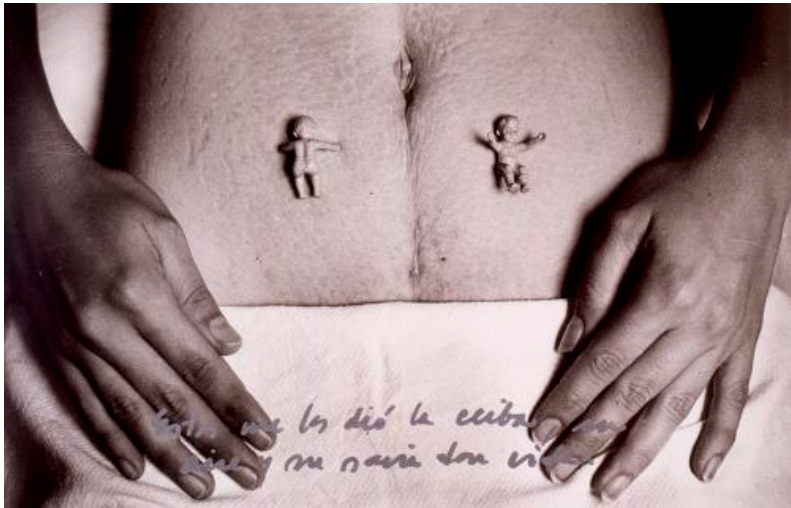
Figure 5. Marta María Pérez Bravo, Estos me los dio la ceiba, su aire y su nacri dan vida (These Were Given